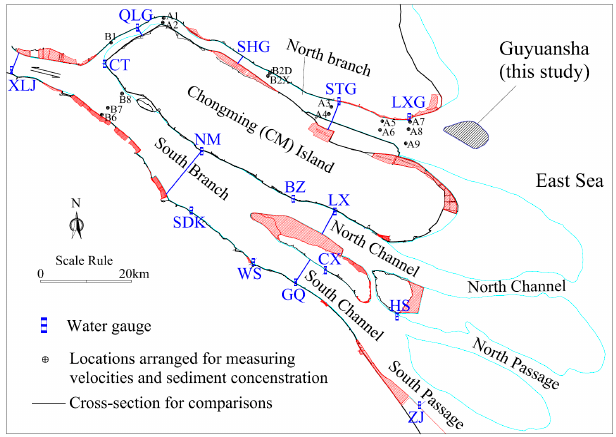
Figure 3. Arrangements of hydrology survey locations in Yangtze Estuary.